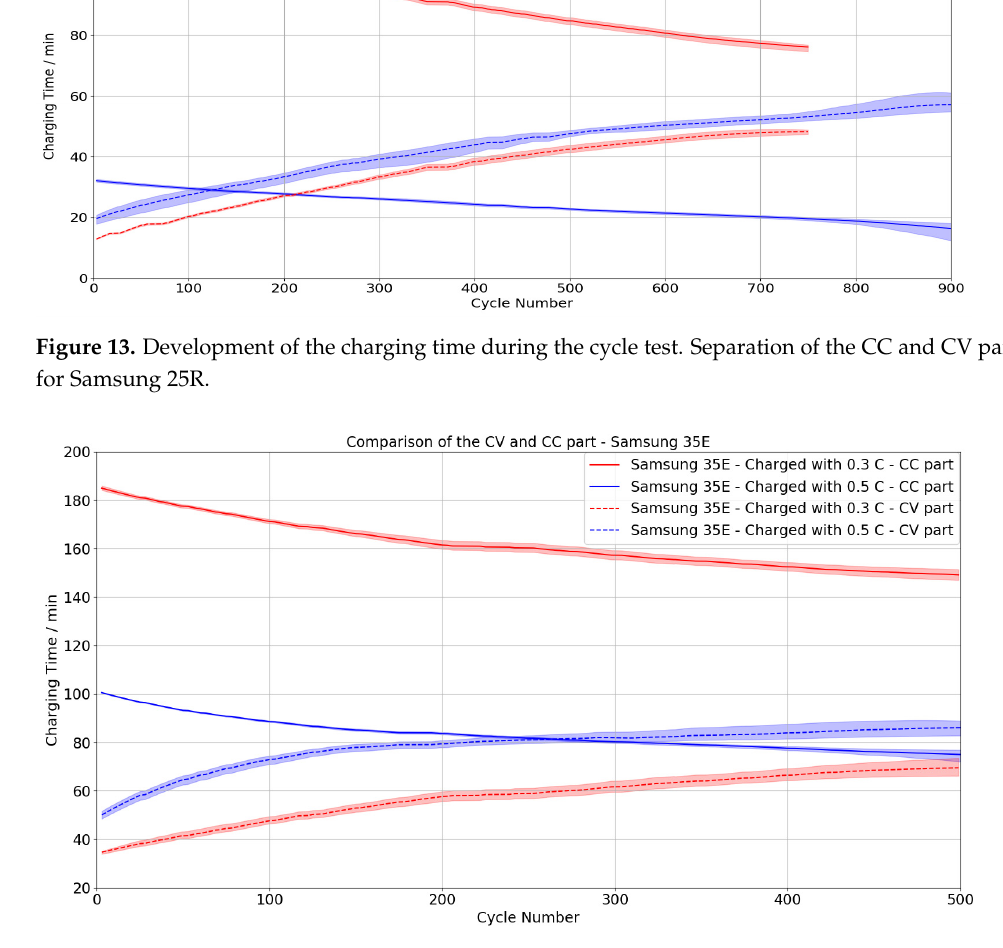
Figure 13. Development of the charging time during the cycle test. Separation of the CC and CV part